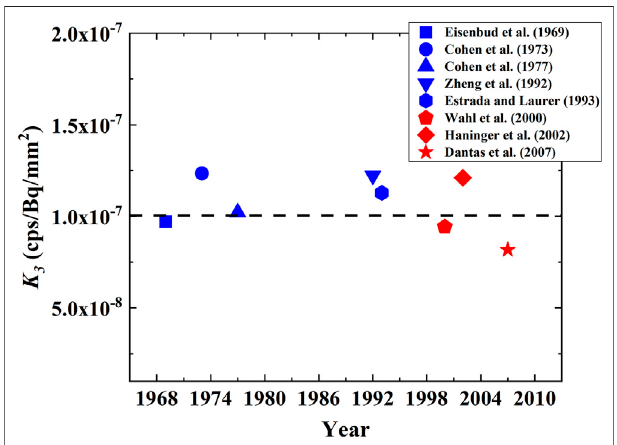
FIGURE 5 | The dependence of MDA on the active area of detector and measurement time, where the fi lled symbols represent the active areas reported in the original studies.